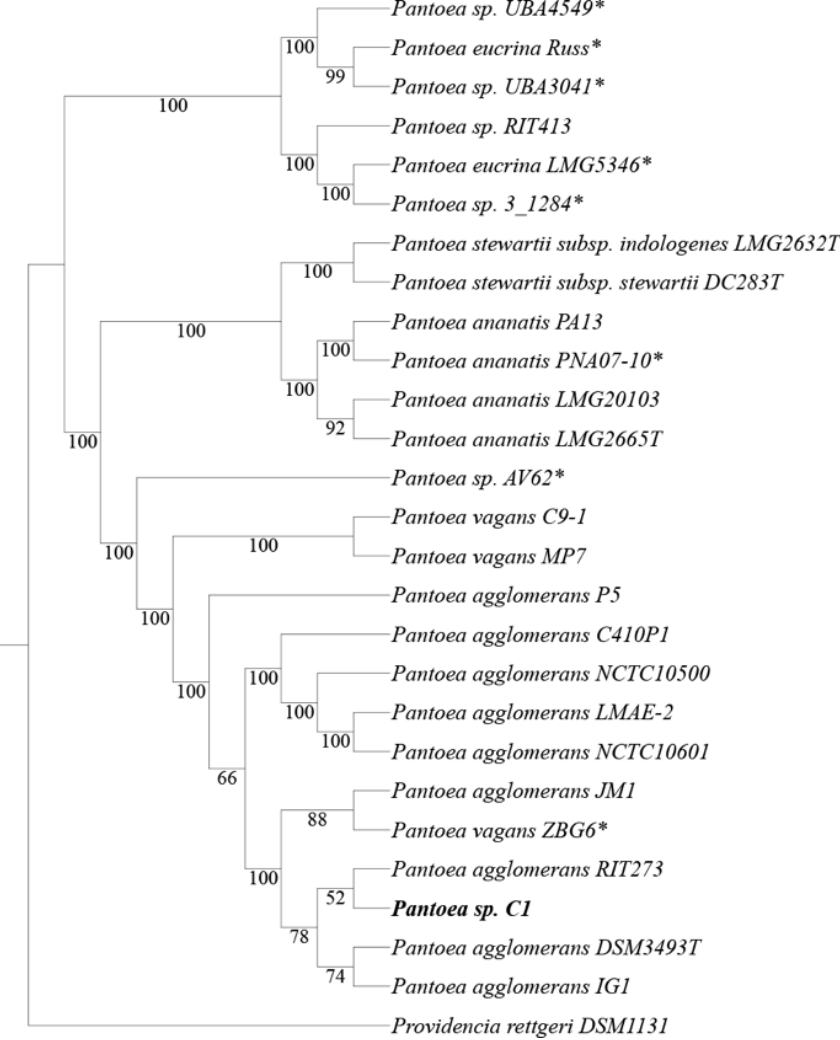
Figure 1. Comparison analysis of strain C1 with other 25 Pantoea strains. The phylogenetic tree was built from user-selected genomes by the FastTree method [25]. Branch labels represent bootstrap support (in percent; 1000 bootstrap replicates). T indicates type strain; the asterisk (*) indicates Pantoea strains that share a highly similar heavy metal resistance gene cluster (see Figure 3). Providencia rettgeri DSM1131 was used as outgroup. Accession numbers are reported in Supplementary Table S1.